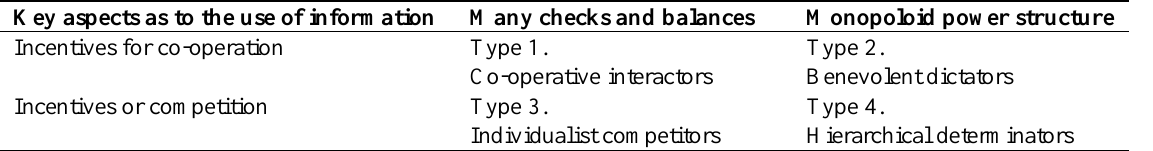
Table 2. Four types of institutional structures Key aspects as to the use of